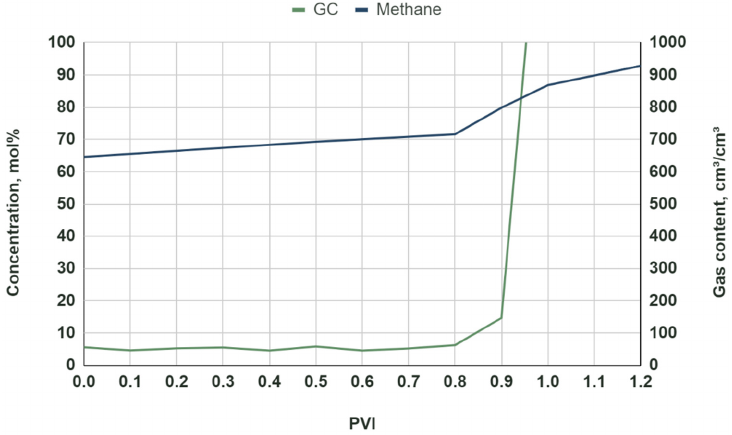
Figure 6. Methane concentration in produced gas, for methane injection at a pressure of 40 MPa.